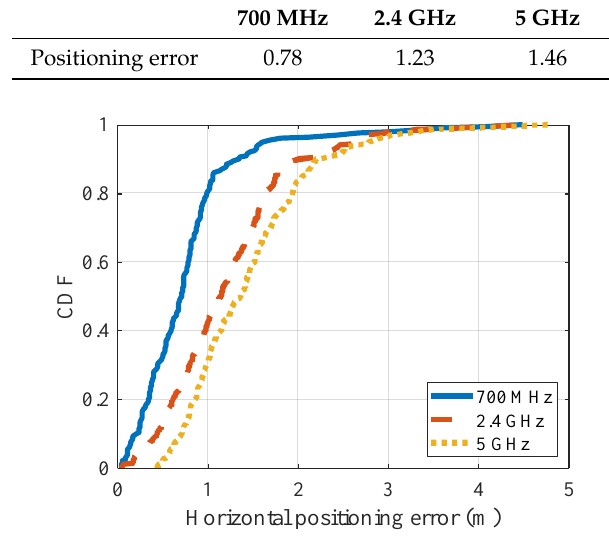
Figure 18. CDF of horizontal positioning error for each frequency. Table 5. Average of horizontal positioning error for each frequency band (m).